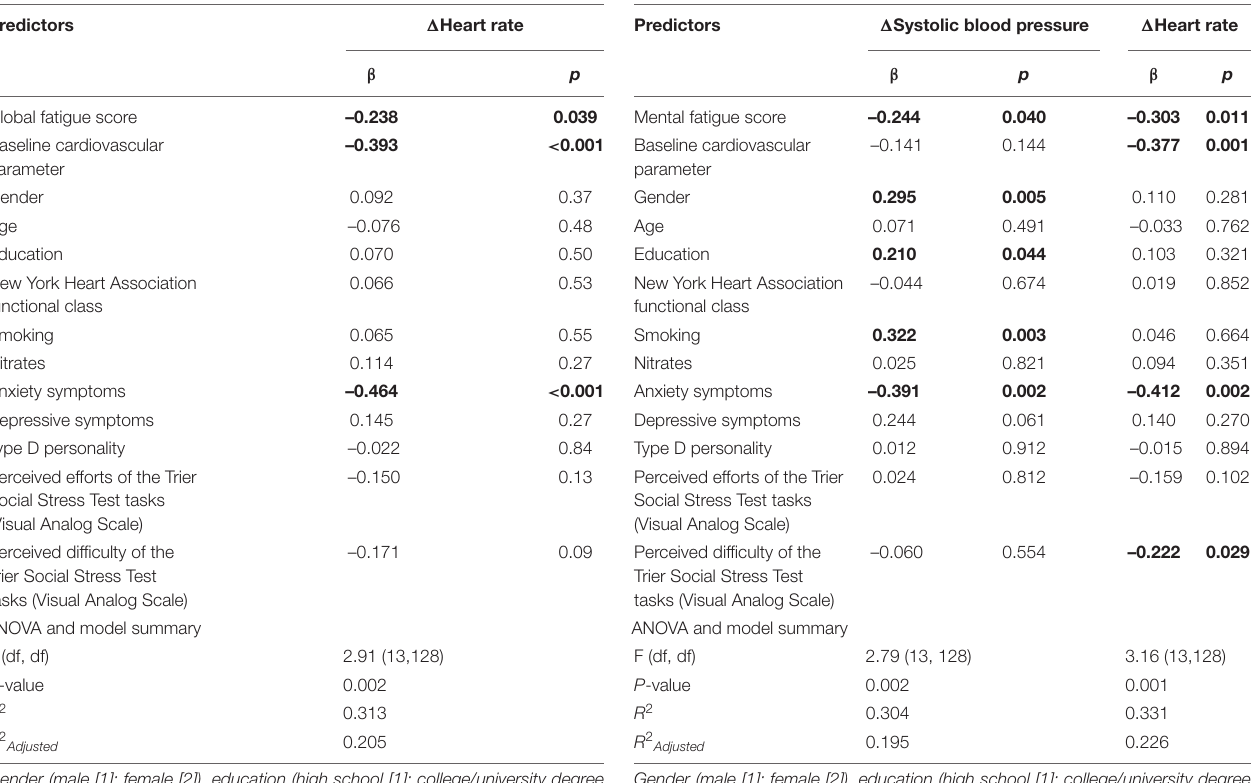
TABLE 6 | Multivariable Linear Regression model, examining mental fatigue score associations with cardiovascular reactivity during Trier Social Stress Test anticipatory stress (task instruction), while controlling for possible